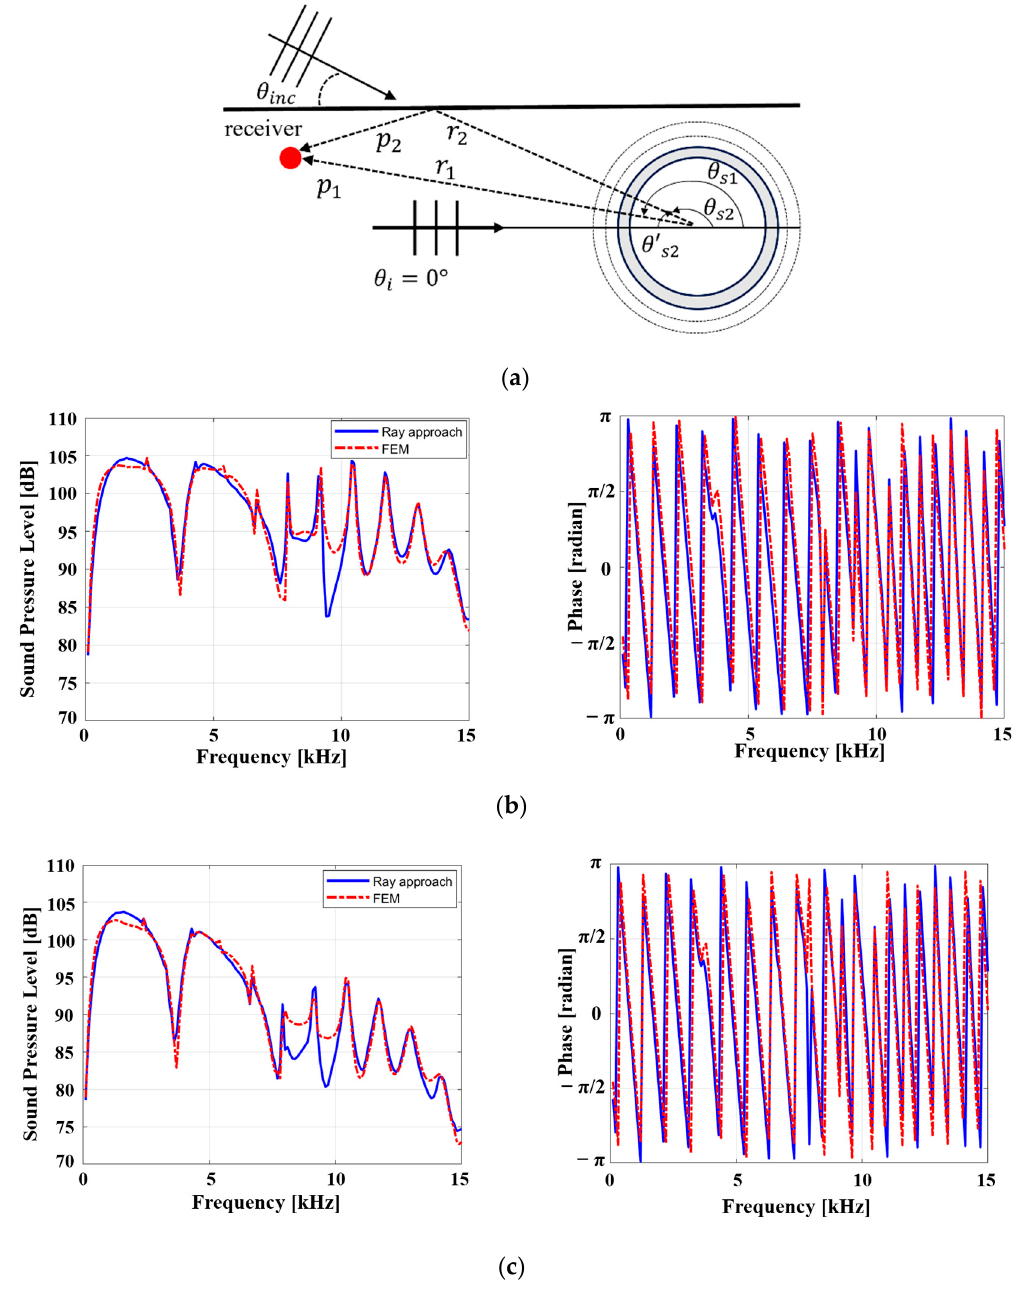
Figure 4. ( a ) Dominant scattered paths for buried target (direct and bottom reflected paths). Com- parison of simulated scattered signals between ray approach and FEM for low-to-high frequencies with respect to amplitude (sound pressure level) and phase when ( b ) neglecting and ( c ) considering bottom attenuation.